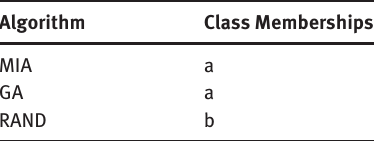
Table 4. Length 52 2 PSK: Tukey HSD Class Memberships.